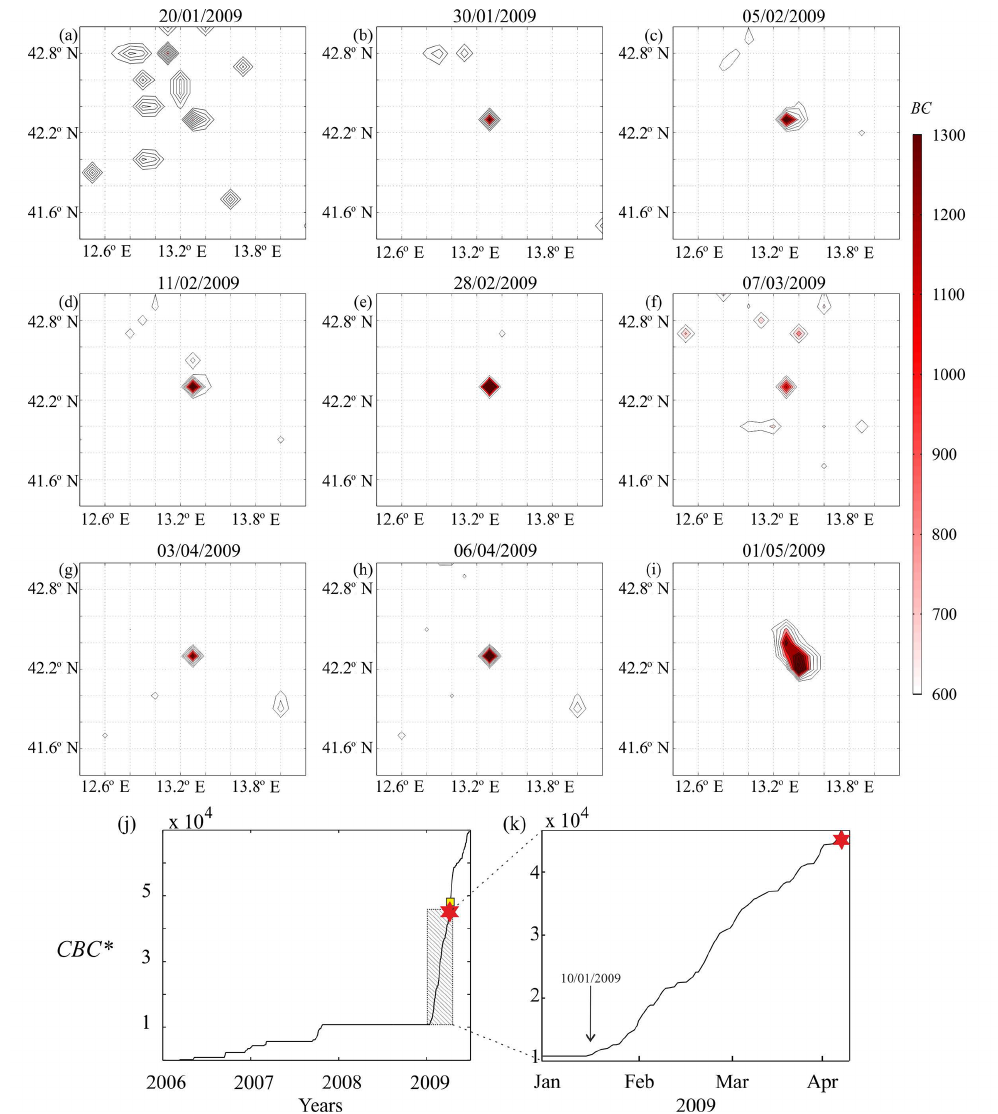
Figure 6. As in Fig. 5 for a space window with radius R 2 = 3 ◦